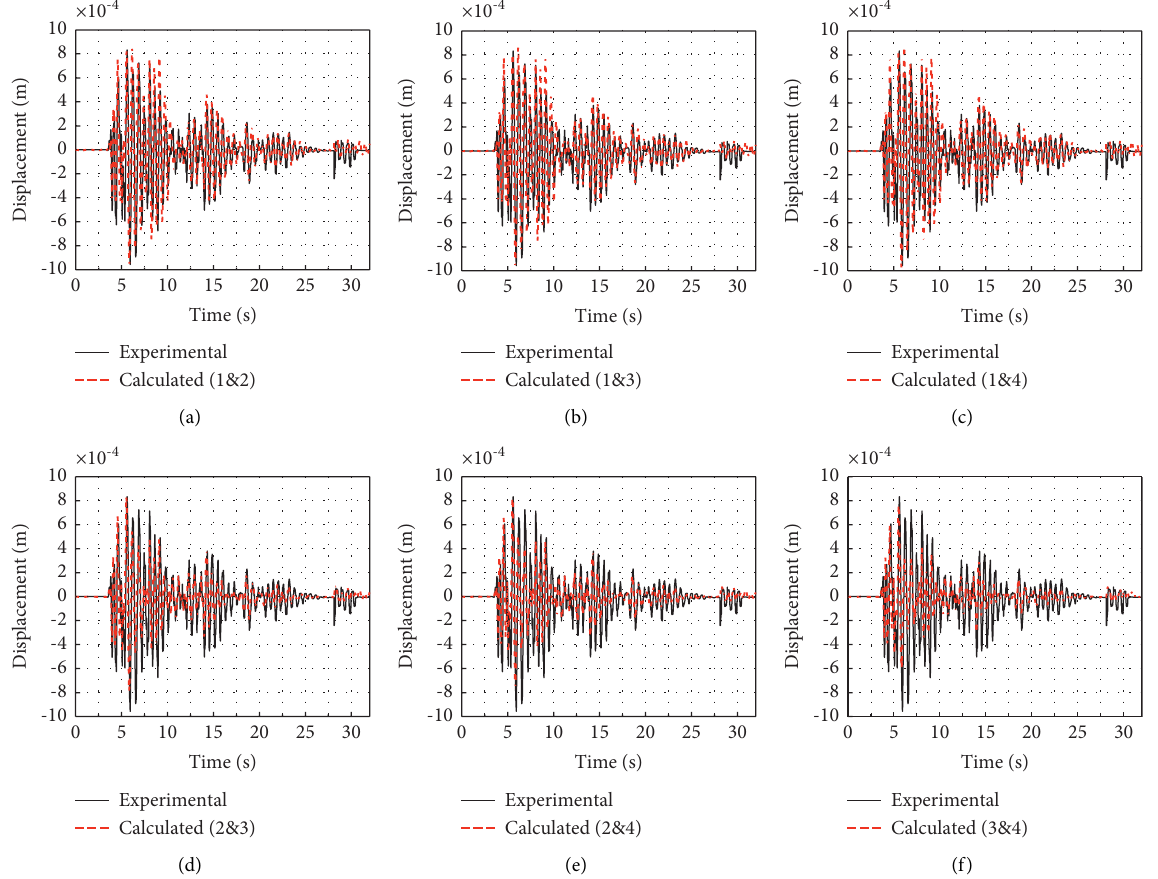
Figure 8: : Comparisons of calculated and experimental displacement curves of the first story with RD based on frequency pairs (case 221): (a) 1&2, (b) 1&3, (c) 1&4, (d) 2&3, (e) 2&4, and (f) 3&4.